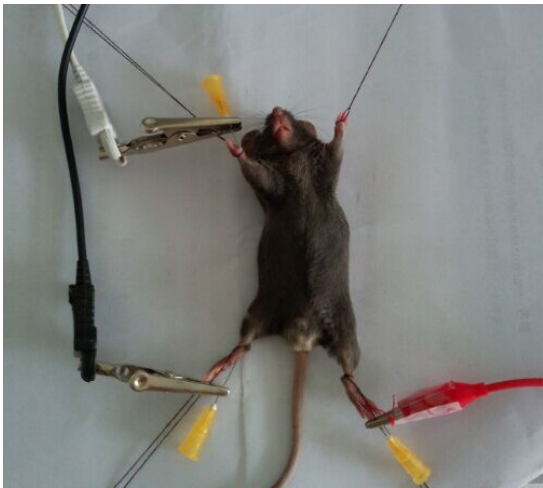
Fig. 3. ECG detection: The experiment use the BIOPAC multi-channel physiological recorder to collect the mouse's electrocardiogram signal, the electrode connection method: VIN þ connects the mouse's left leg, VIN- connects the mouse's right upper limb, GND connects the mouse's right leg.